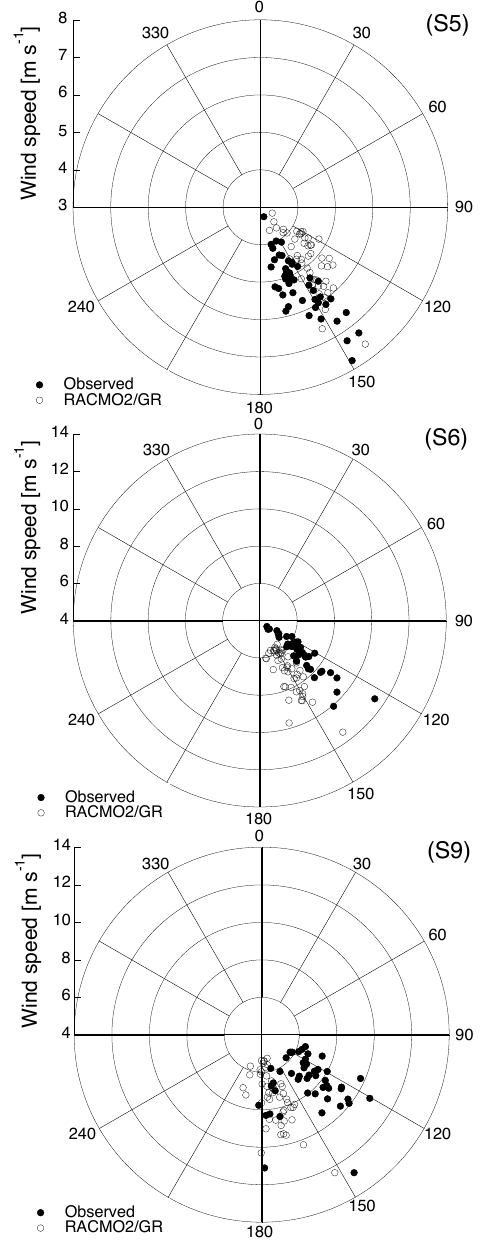
Fig. 8. Comparison of simulated (open circles) and observed (solid circles) monthly averaged 10m wind direction and speed at S5, S6 and S9 for the measurement period August 2004–August 2007.